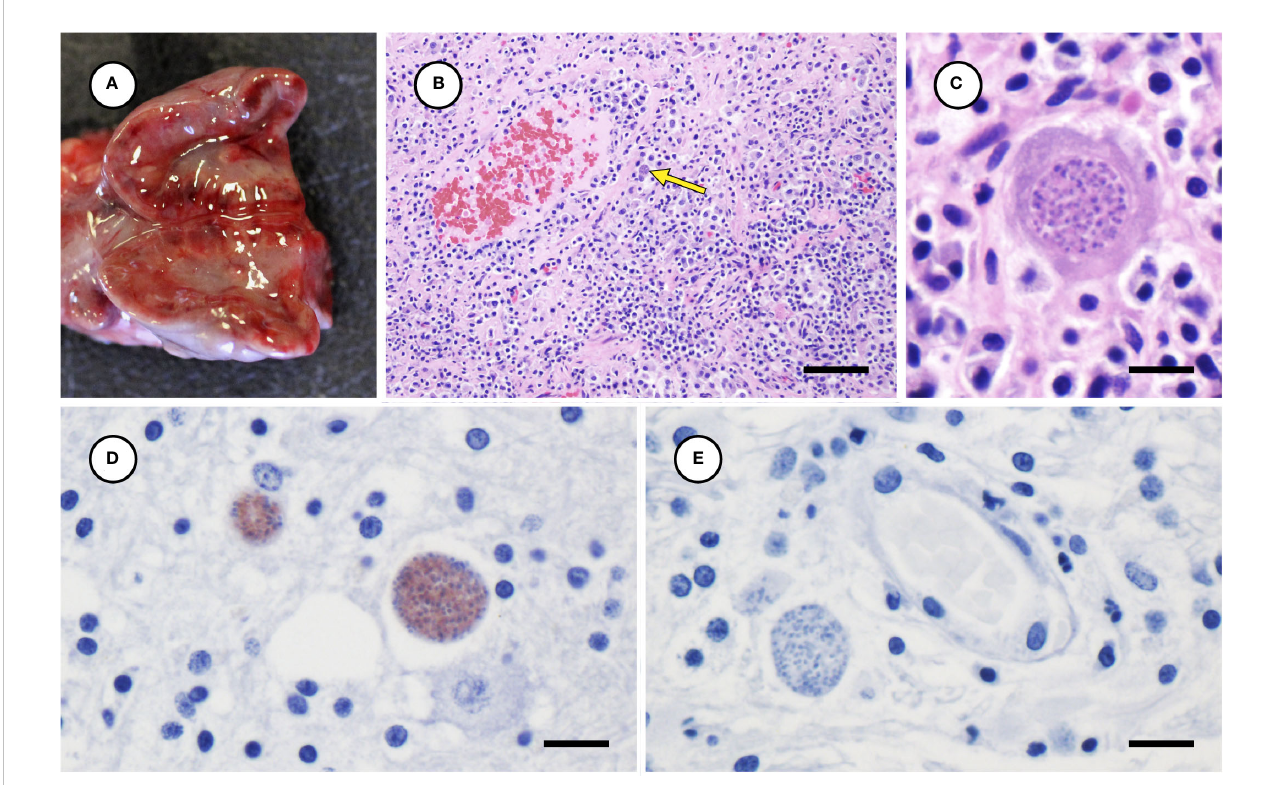
FIGURE 6 Congested, hemorrhagic and edematous adrenal gland from a sea otter with fatal toxoplasmosis and steatitis (A) . Low (B) and high (C) magni fi cation microscopic views of markedly in fl amed adrenal medulla from the same sea otter demonstrating intralesional Toxoplasma gondii -like protozoa (indicated by arrow for B) (H&E stain, bar = 40 and 10 µm, respectively). Immunohistochemical stains of mildly in fl amed brain tissue from sea otters with fatal toxoplasmosis and steatitis, demonstrating relatively mild in fl ammation and strong positive immunostaining of intralesional tissue cysts for T. gondii (D) , and negative immunostaining of brain parasites for Sarcocystis neurona (E) ( D , E : bar = 10 and 10 µm,